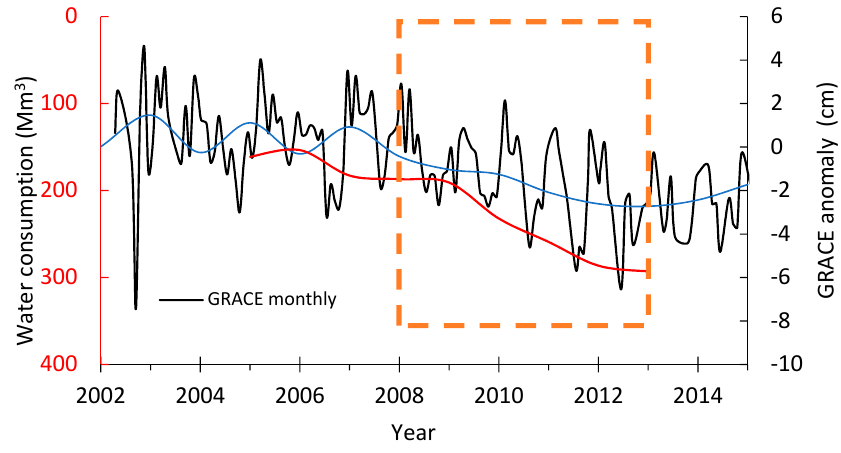
Figure 4. Grace Anomaly of Al Ain and the water consumption for the city from Abu Dhabi Water and Electricity Authority (ADWEA).